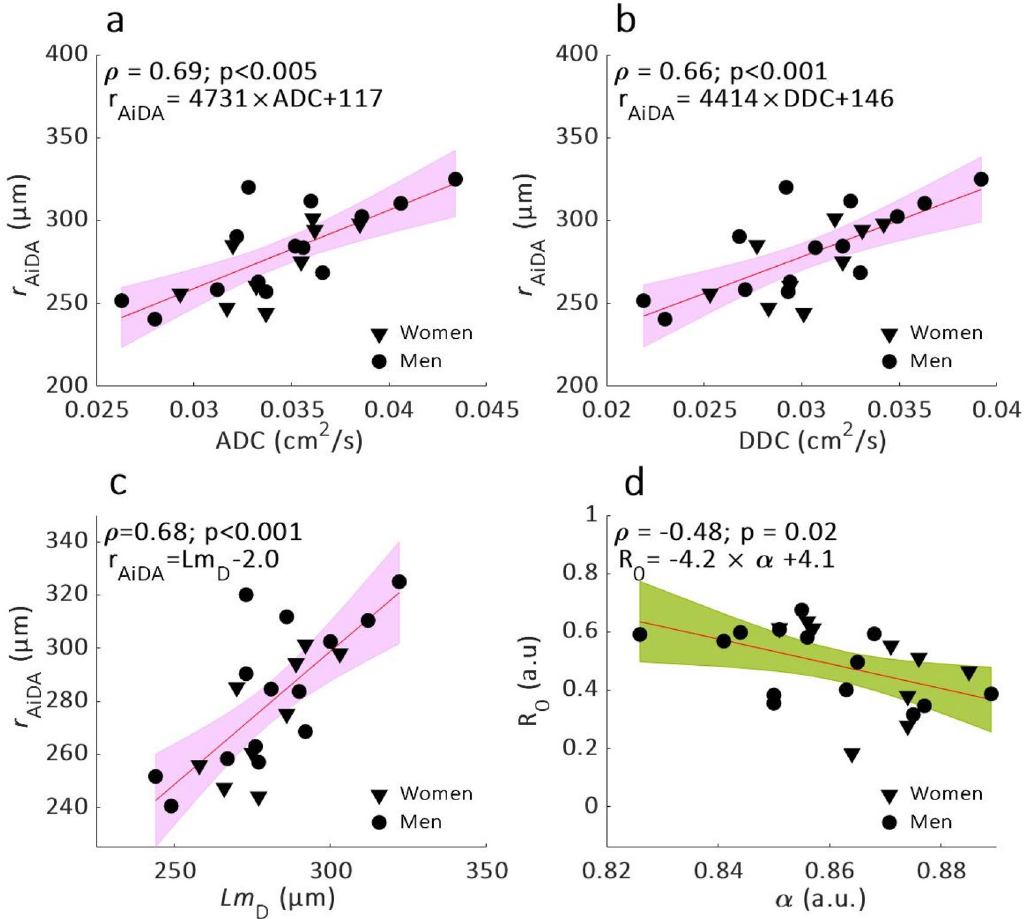
Figure 1. Linear regressions (with 95% confidence intervals in color) and Spearman’s correlation (ρ) of r AiDA as a function of 129 Xe DW-MRI metrics: ( a ) ADC, ( b ) DDC, ( c ) Lm D and of R 0 as a function of α heterogeneity index ( d ).